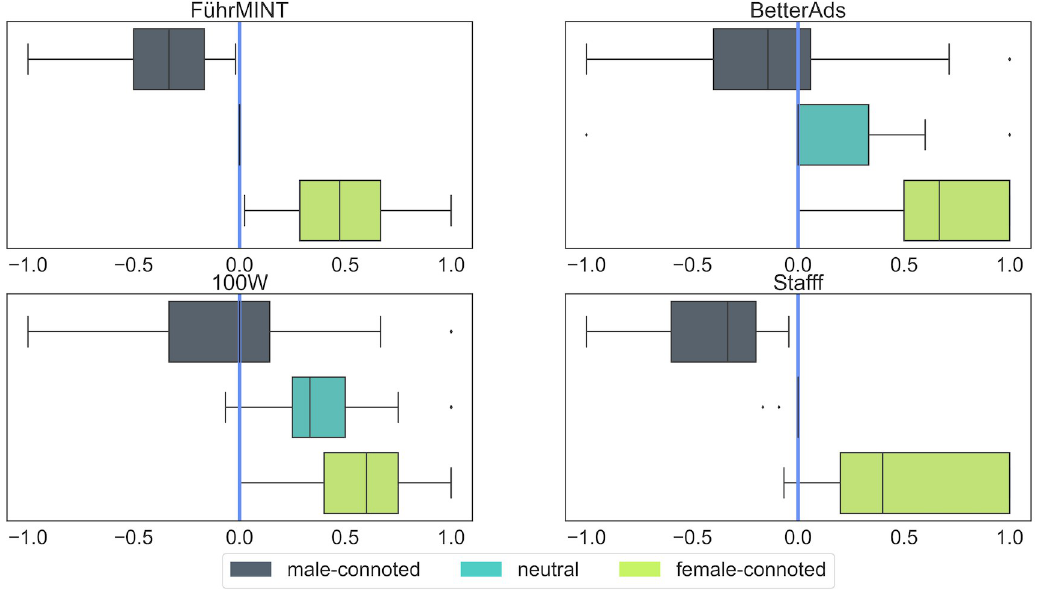
Fig 9. Center and spread of simplified gender scores. The vertical lines refer to the simplified threshold between the gender categories, equal for all four technologies.